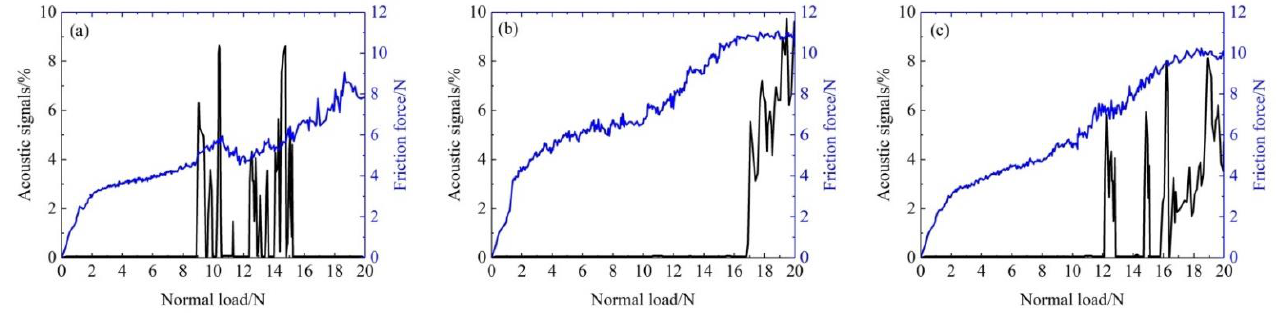
Figure 8. Acoustic signals and the friction force of all composite coatings. ( a ) S2 sample; ( b ) S3 sam- ple; ( c ) S4 sample. sample; ( c ) S4